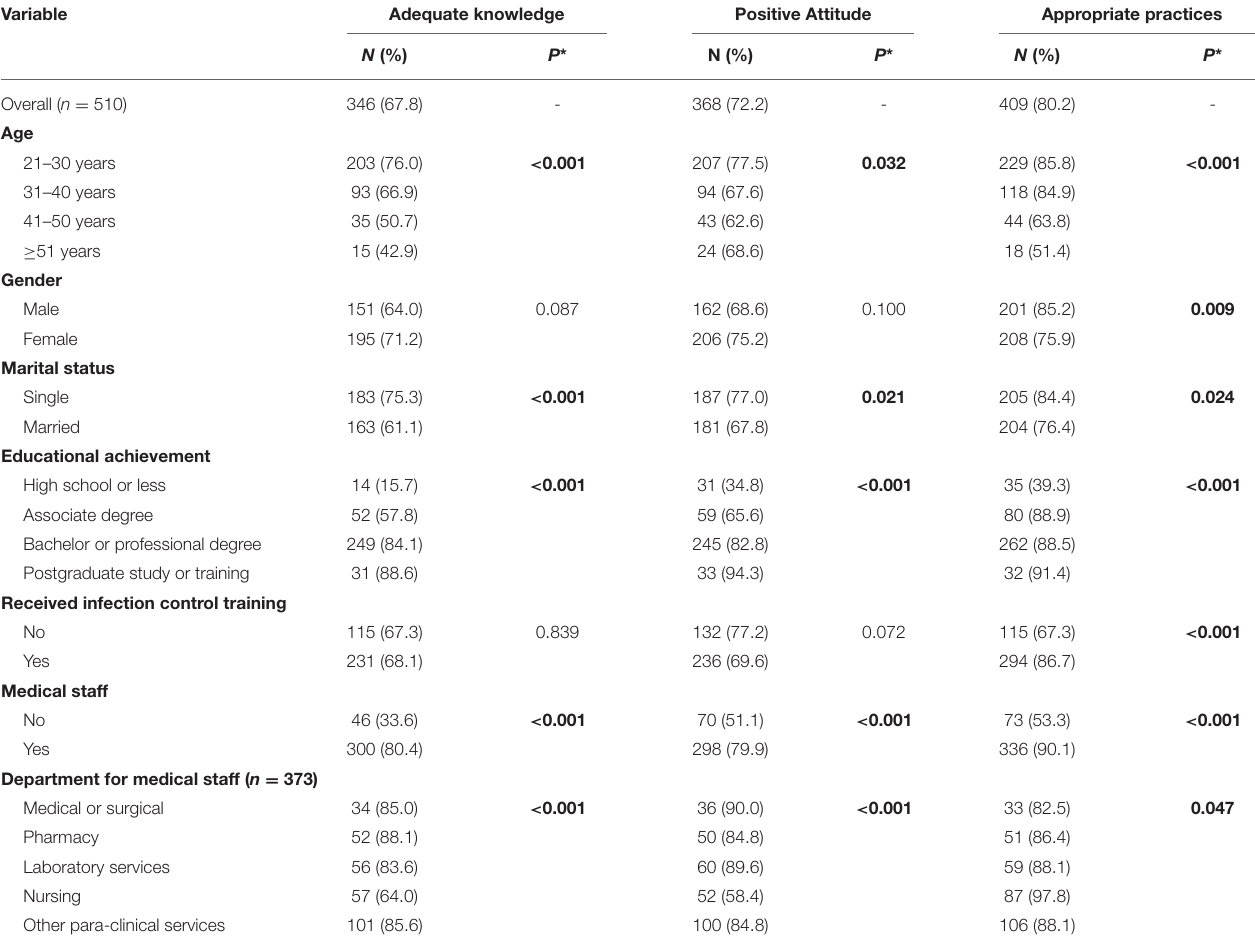
Values in bold represent significant results. * P-values were from Chi-square